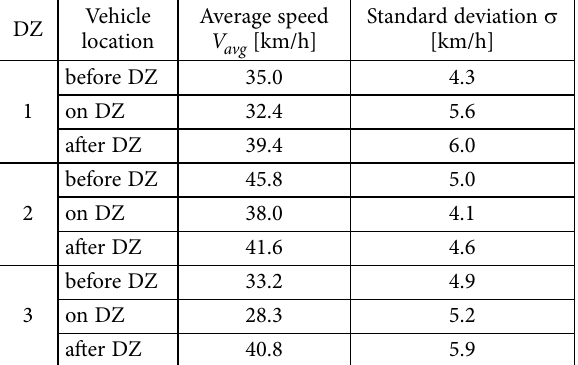
Table 2. Descriptive statistics of vehicle speeds before-on-after DZs